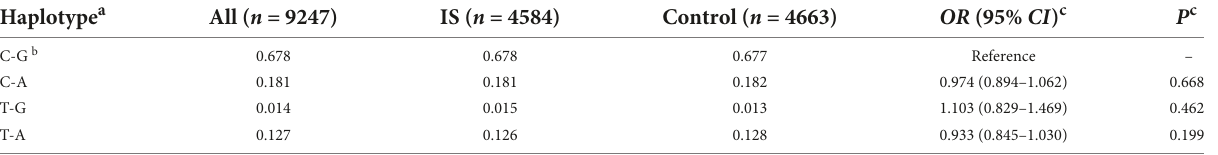
TABLE 4 Association analyses of THBS1 variants with the incidence risk of ischemic stroke in the cohort study. SNP Genotype